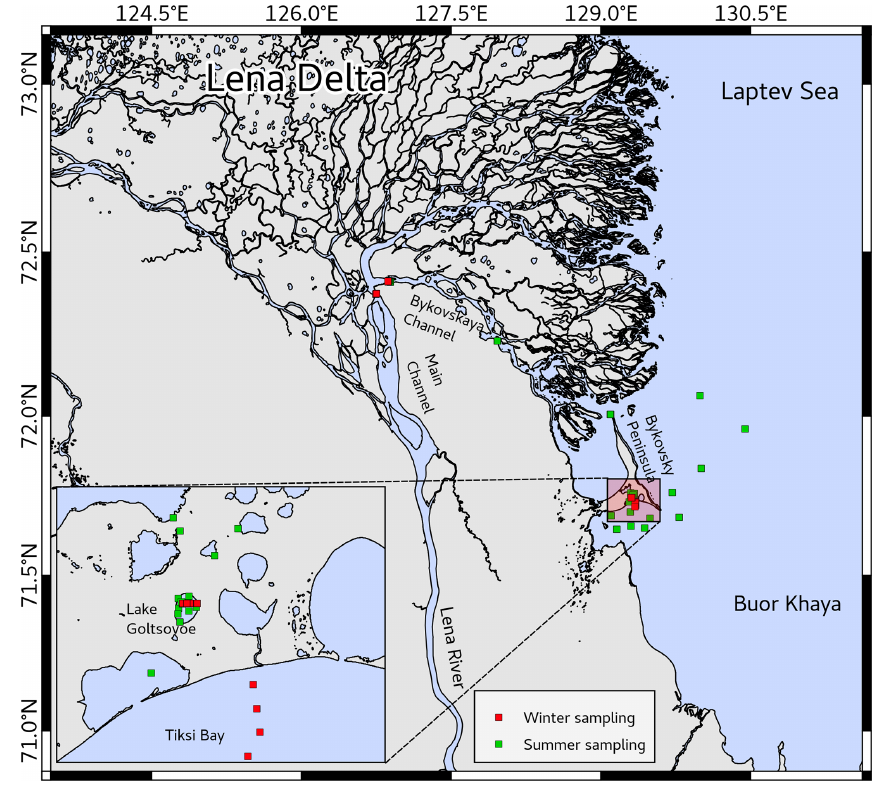
Figure 1. Map of the study area in the Lena River and Buor-Khaya Bay (Siberia, Russia). The inset shows details of the sampling at Lake Golzovoye. Sampling locations in winter are shown in red and summer sampling locations in green. Created by Bennet